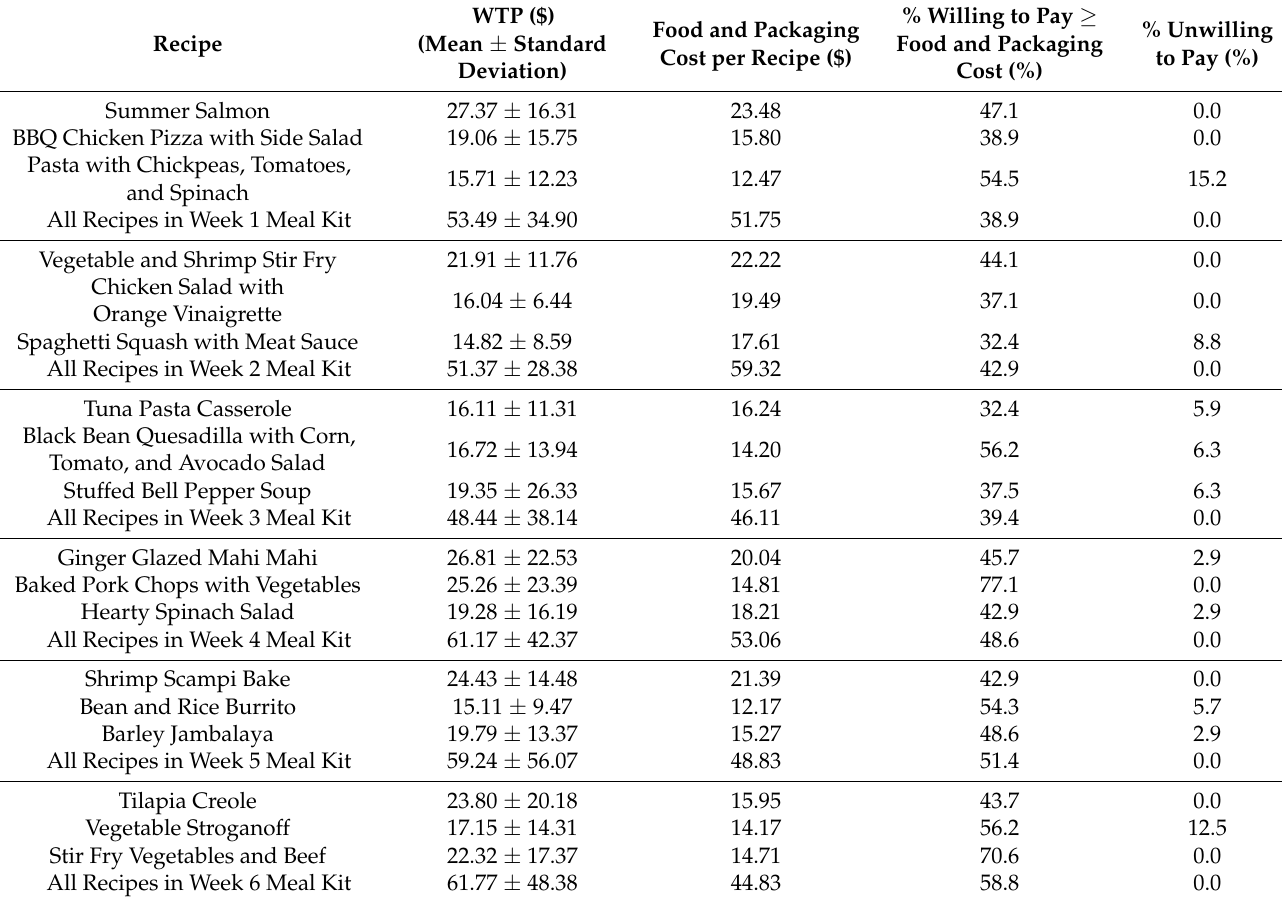
Table 4. Participant WTP and Costs per